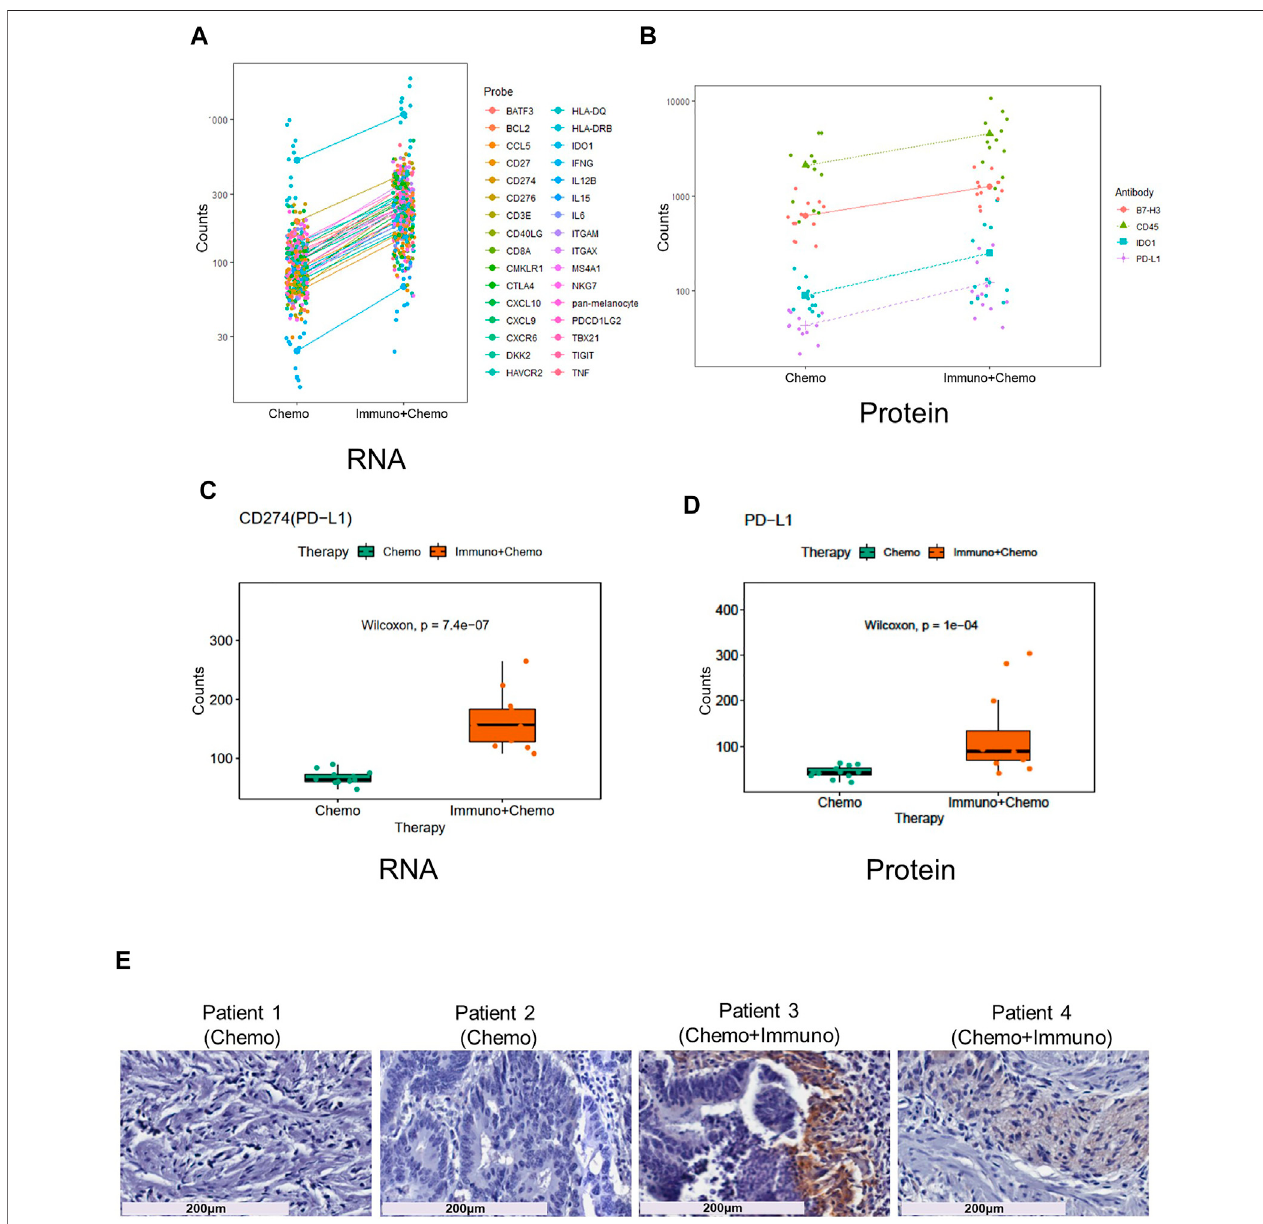
FIGURE 3 | Increased immune response and elevated PD-L1 expression in combinational therapy – treated patients within the tumor ROIs. Line charts of differentially expressed mRNA (A) and protein (B) within the tumor regions between the treatment groups. Y-axes are untransformed expression raw count values of individual probes. Boxplots of PD-L1 mRNA (C) and protein (D) expression in ROIs of chemotherapy- and combinational therapy – treated groups (the Mann – Whitney test p < 0.05,non-adjusted). (E) PD-L1IHC stainingofpatienttissuesreceivingchemotherapyorcombinationaltherapies.Magni fi cationisshown at20x(scalebar (cid:1) 200 μ